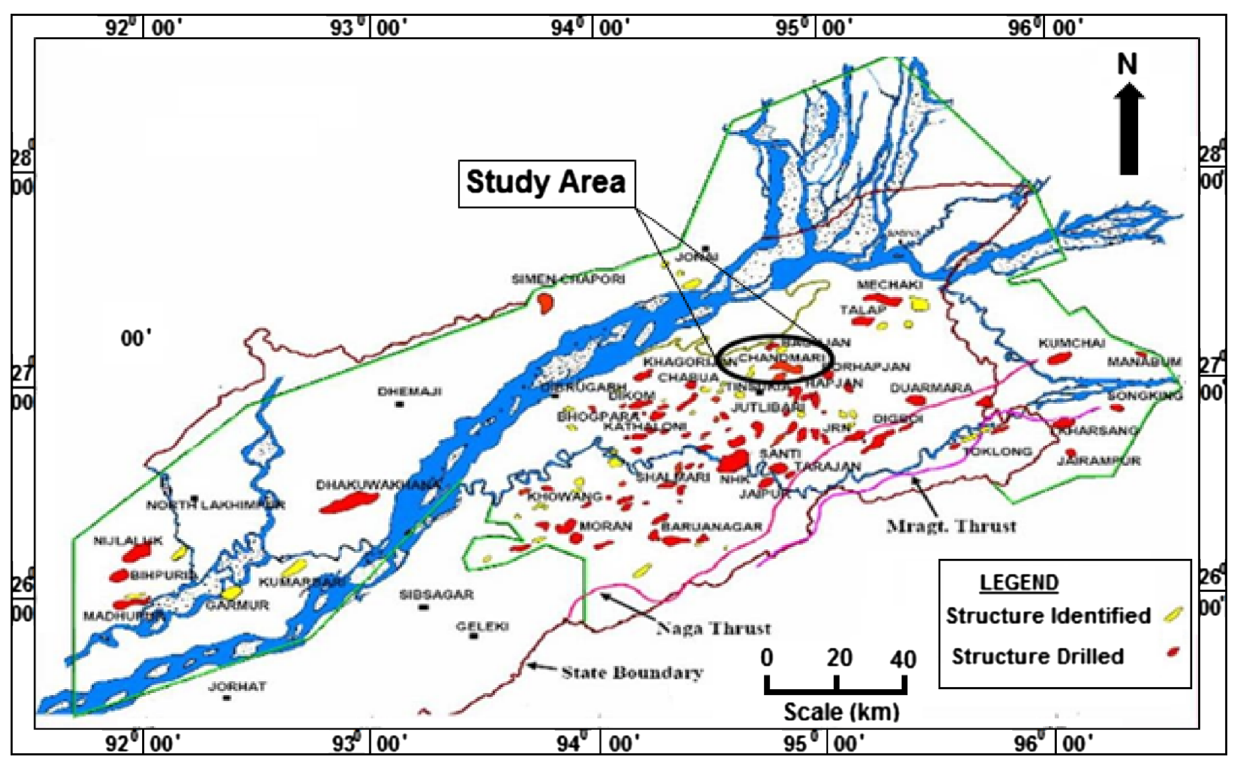
Fig. 1 Location map of study area in Upper Assam Shelf (after Mandal and Dasgupta 2013) Table 1 Availability and non-availability of conventional log data of six wells Well